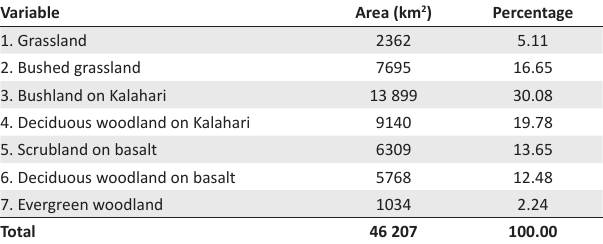
TABLE 2: Area and percentage cover of each vegetation structure class. Variable